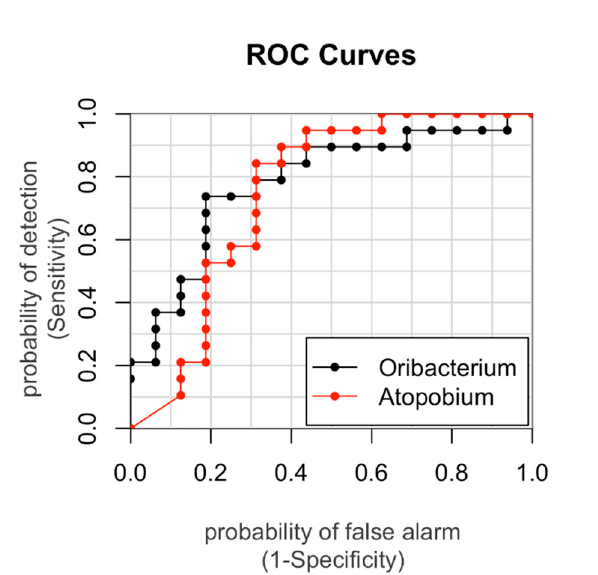
Figure 4. The areas under the Receiver operating characteristic curves (AUROCs) represent the specificity and sensitivity of the Amplicon Sequence Variants. The AUROC was calculated for those genera significantly different among the groups in order to identify those able to discriminate a specific group. Those assigned to Atopobium and Oribacterium had AUROCs of 75% and 78%, respectively. AUROC > 0.7 was considered suitable in discriminating with accuracy.